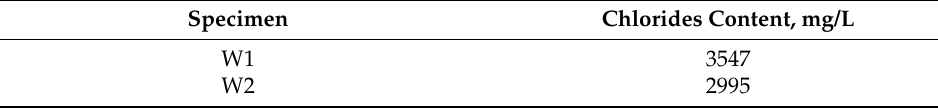
Table 7. The chloride content in the water of the Kłodnica